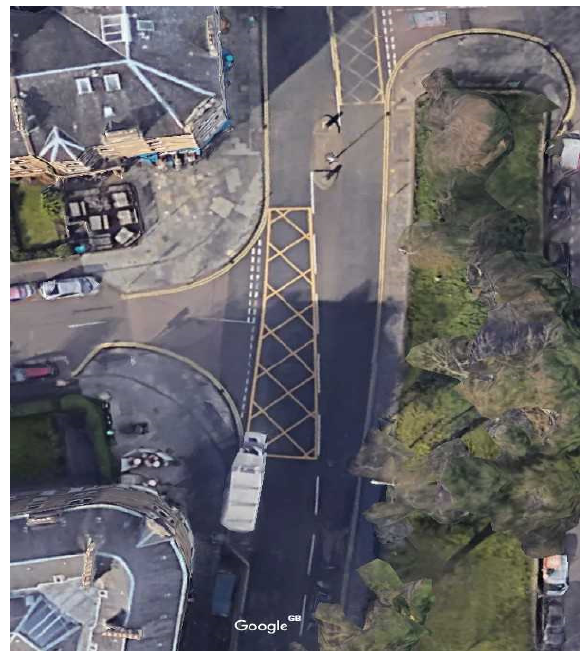
Figure 2. View of the location.